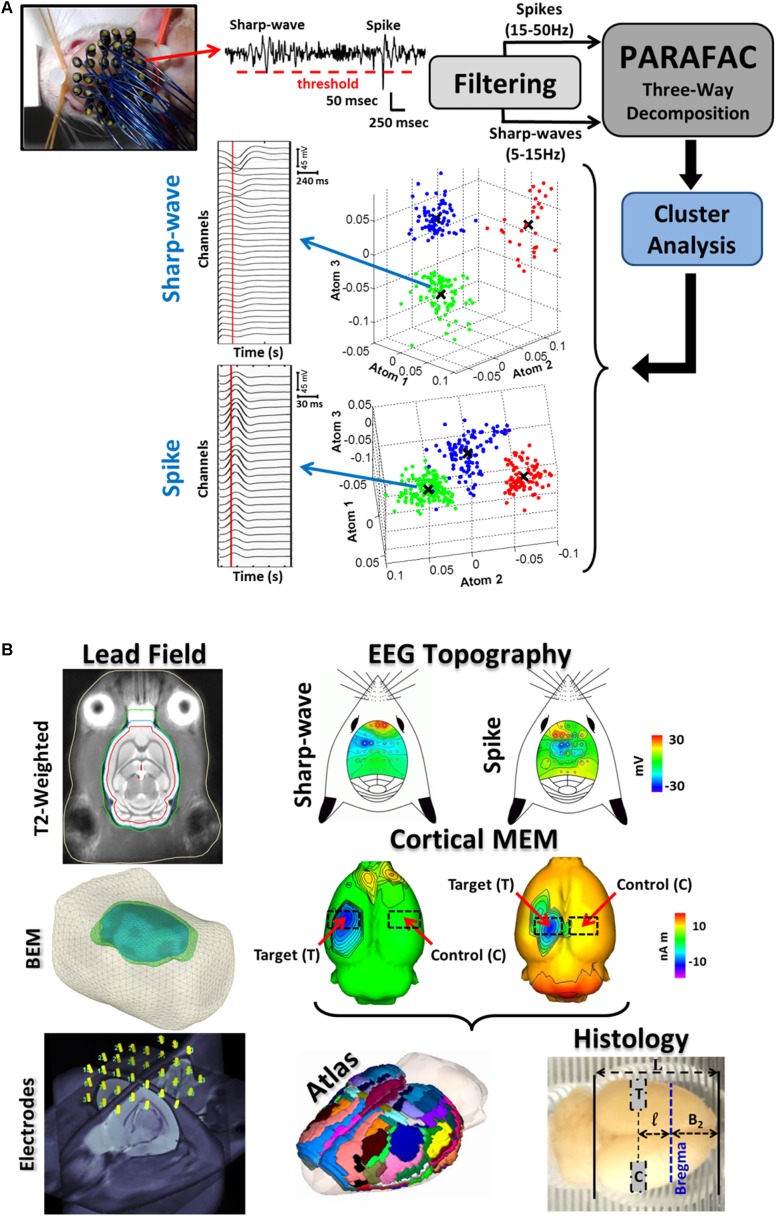
Illustration of the entire methodology for the IED-based brain source imaging (BSI) and immuno-histology. (A) 32-channel EEG recording were obtained with the EEG-mini cap. A thresholding method (red-dashed horizontal line) was used to detect the IEDs from the 32-channel scalp EEG (top-left, a single channel is illustrated). IED spike (20–70 ms in duration) and sharp-wave (70–200 ms in duration) waveforms were separated by means of multiple band-pass/notch filters (spikes: 15–50 Hz and sharp-waves: 5–15 Hz). Both signals were classified into subtypes by combining the parallel factor analysis (PARAFAC) and the k-mean cluster method. PARAFAC allows decomposing the topographic maps and temporal courses of IED subtypes as combination of spatial and temporal atoms, reducing uncertainty in IED classification. The atom-based 3D plots for both spikes and sharp-waves represent separable subtypes (clouds of different colors). Note that each dimension of our three-way data represents space (channels), time, and sample (IEDs). Each subtype of IEDs was considered as a unique epileptiform event. Mean time courses for each IED subtype were obtained by averaging over samples of the same cluster (i.e., mean value X). (B) For each rat, electrodes on the EEG mini-cap were co-registered to our T2-weighted probabilistic atlas and template. Segmentations of different surfaces (e.g., cortex, inner/outer skull and scalp) of this T2-weigthed template image were used in the boundary element method (BEM) to estimate the lead field matrix needed to solve the EEG inverse problem for each rat. IED source localization is believed to be more accurate at the 2/3 of the IED peak (vertical red lines in the IED average time series). The corresponding IED topographic map for each subtype reveals localized cortical activation in most of the cases. sLORETA inverse solution shows the specific cortical source locations and its contralateral non-activated counterpart (red arrows). Cortical current generators for each IED subtype were co-registered with the T2-weighted probabilistic atlas using procedures described in Bae et al. (2015). The cortical regions with maxima current amplitudes in the 2/3 initial phase of each IED were selected as target areas (T), and the corresponding contra-lateral healthy regions as controls (C). The co-registered sLORELA inverse solution (left) is in the Paxinos-Watson’s coordinate system, so actual cortical regions can be identified according to the convention in Table 2 (Atlas, middle panel). Brains were scaled according to the formula in Section “Materials and Methods” and blocks for histology were cut using a scaled brain matrix (right).